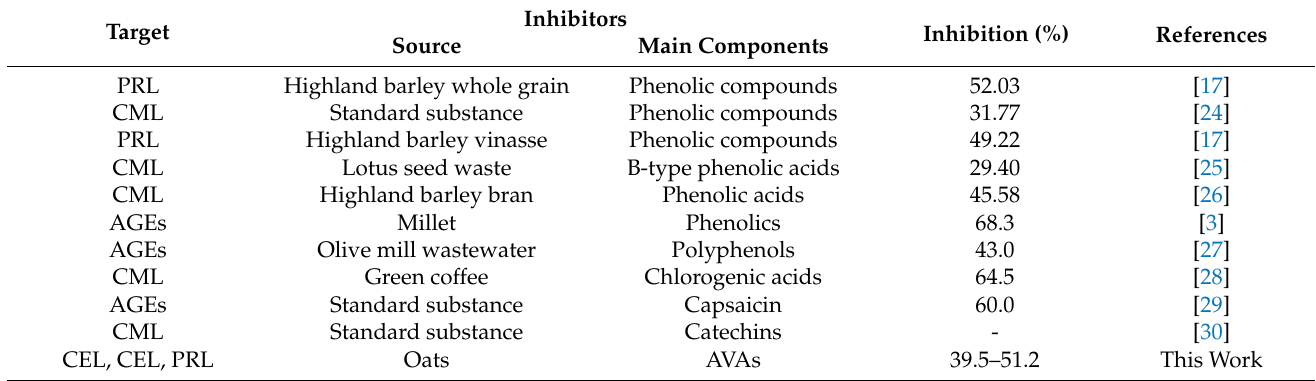
Table 1. Summary of studies on AGE inhibition by different